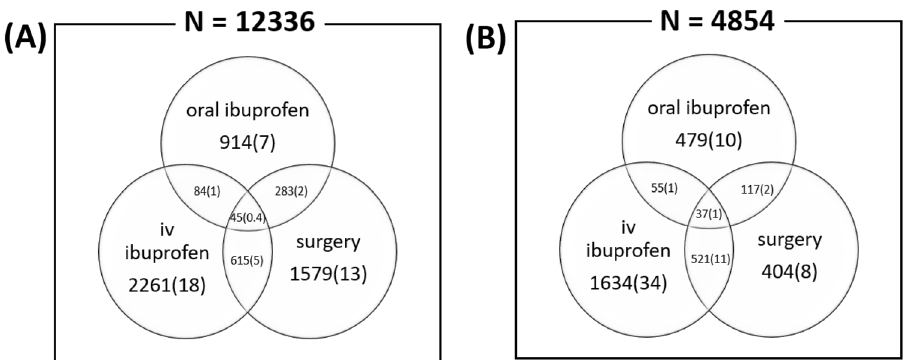
Figure 1. Distribution of PDA treatment strategy among the ( A ) neonate and ( B ) VLBW infants in